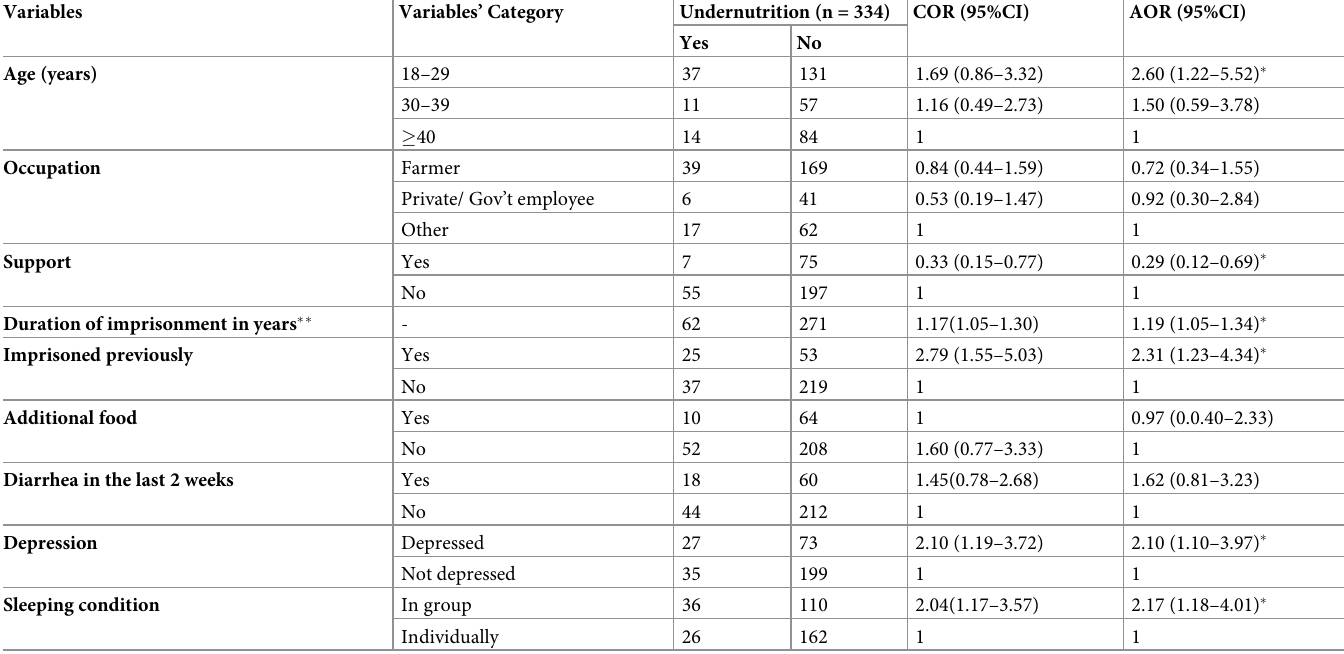
Table 3. Multivariable logistic regression model for factors associated with undernutrition among incarcerated people in Mizan prison institute, southwest Ethio- pia, 2020 (n =